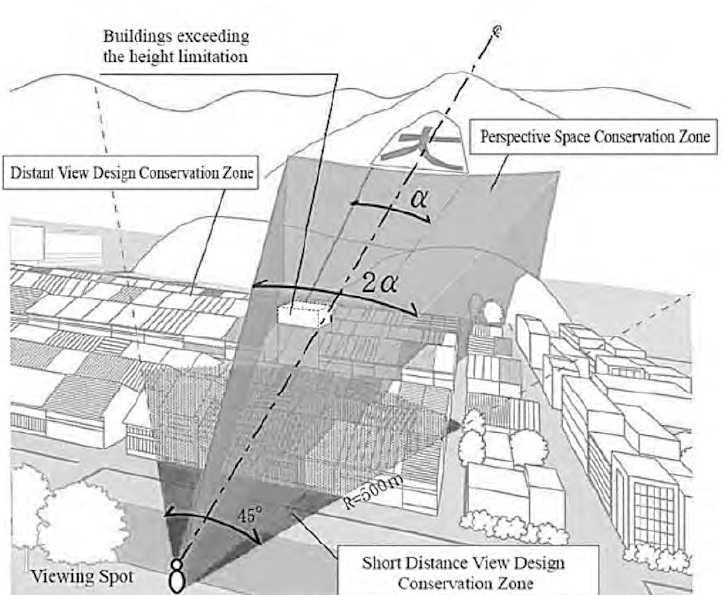
Figure 1. Heights limitation to protect mountain views Source: Kyoto Landscape.Kyoto City Bureau